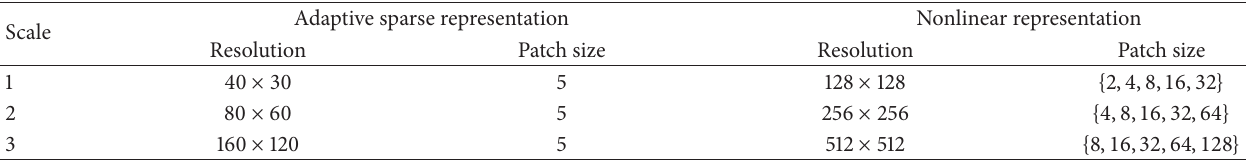
Table 2: Various scales parameters which are used for evaluation of sparse and nonlinear representation.